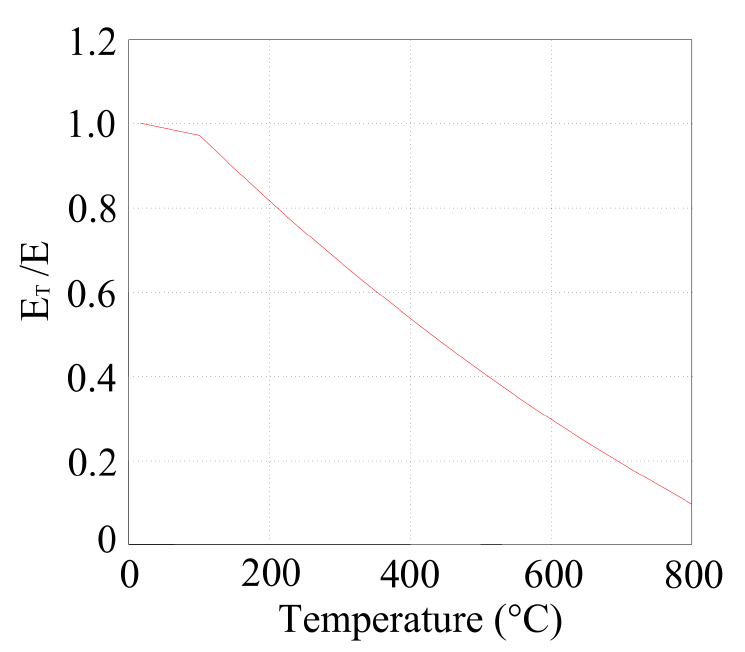
Figure 9. Young’s modulus of tunnel lining with different temperatures expressed by Equation